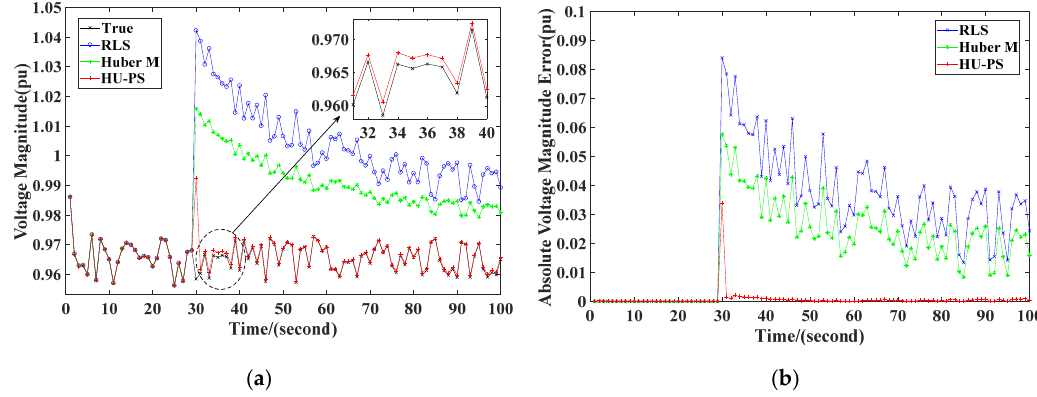
Figure 4. Values in scenario 1: ( a ) voltage magnitude, ( b ) absolute voltage magnitude error.